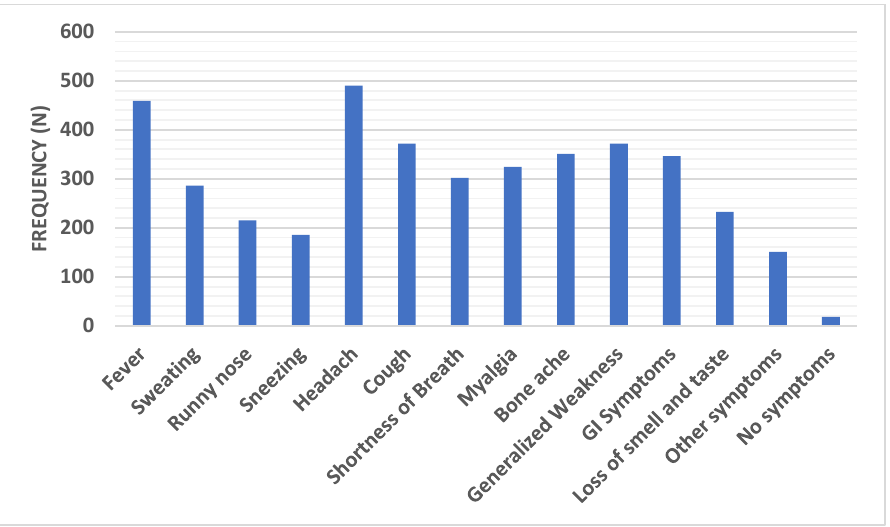
Figure 2. Distribution of the common symptoms among COVID-19 group. Data were presented as frequency (number).